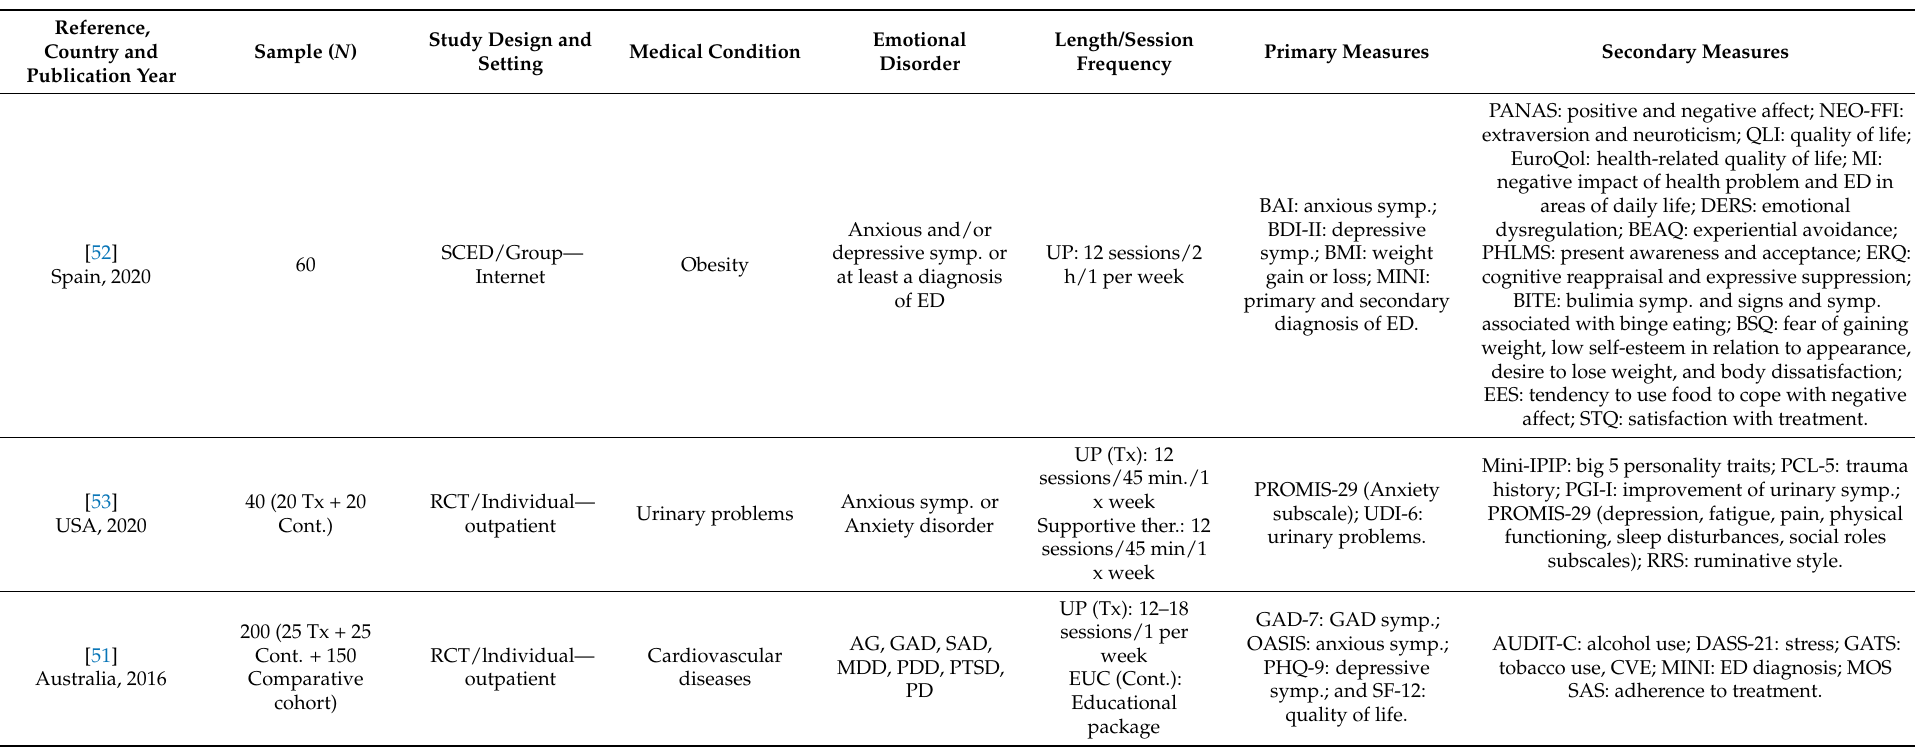
Table 4. Characteristics of the included study